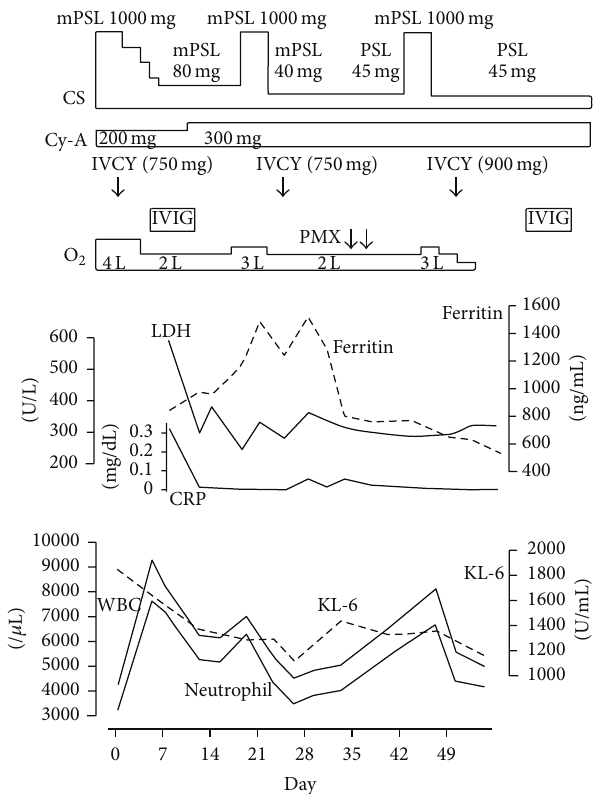
Figure 1: Time course of medical treatments and changes in the lab data before and after treatment. CS: corticosteroids; mPSL: intravenous methylprednisolone including pulse therapy; PSL: oral prednisolone; Cy-A: cyclosporine A; IVCY: intravenous cyclophos- phamide therapy; IVIG: intravenous immunoglobulin (20 g/d for 5 days); PMX: polymyxin B-immobilized fiber column hemoperfu- sion; O 2 : oxygen supplied with nasal cannula; LDH: serum lactate dehydrogenase; ferritin: serum ferritin level; CRP: serum C-reactive protein; KL-6: serum sialylated carbohydrate antigen KL-6 level; WBC: white blood cell count; neutrophil: neutrophil